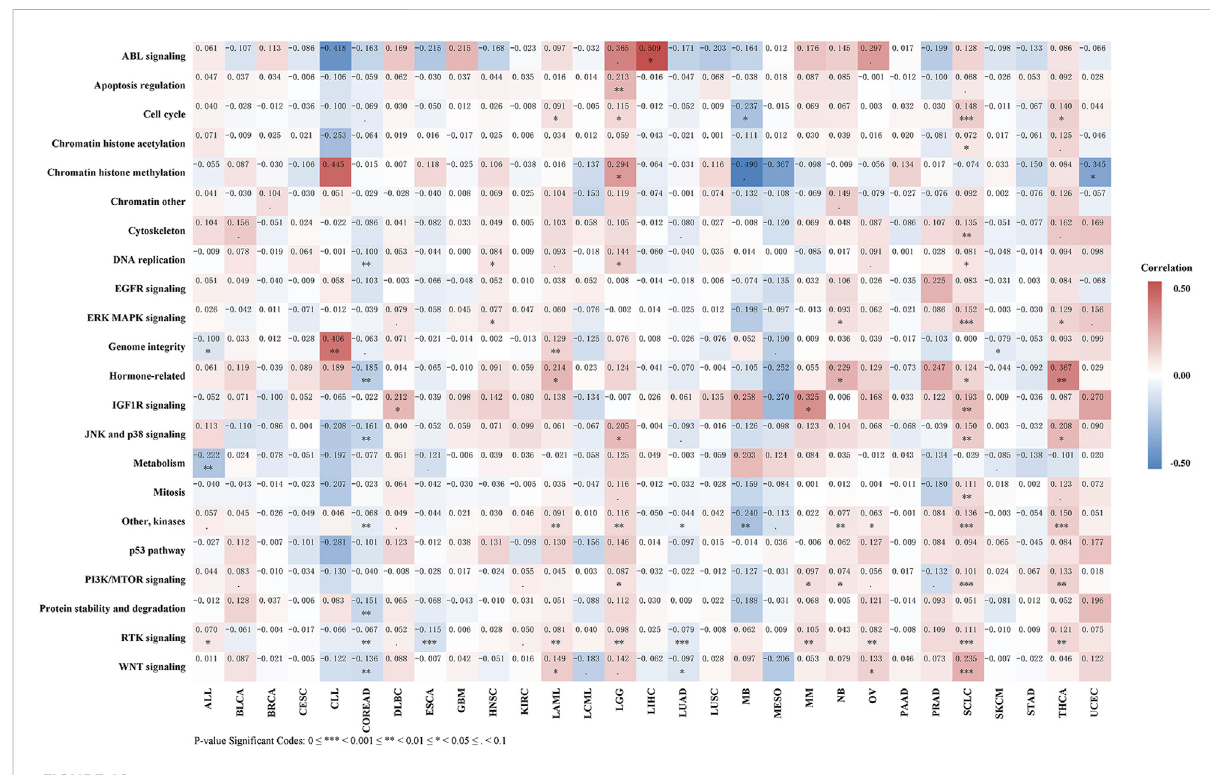
FIGURE 10 Correlation heatmap of REV1 expression and drug pathway ’ s IC50 in different